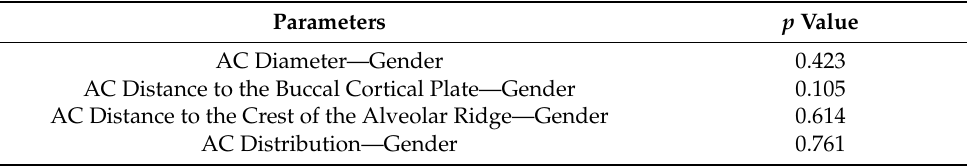
Figure 4. Axial CBCT slices from a patient with an exposed AC which ends at the palatal cortical border. The green arrow shows the nasopalatine canal, while the red arrow shows the AC. Note that in some slices an AC as wide as the nasopalatine canal can be seen. Table 2. Statistical analysis of the parameters among females and males.